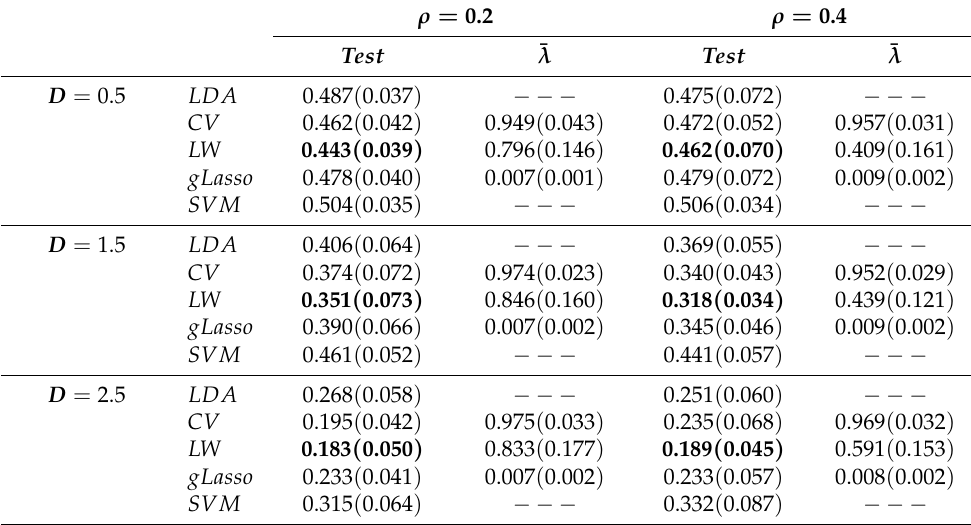
Table 1. Misclassification error and shrinkage parameter values for Mod1. ρ = 0.2 ρ = 0.4 Test ¯ λ Test ¯ λ D =